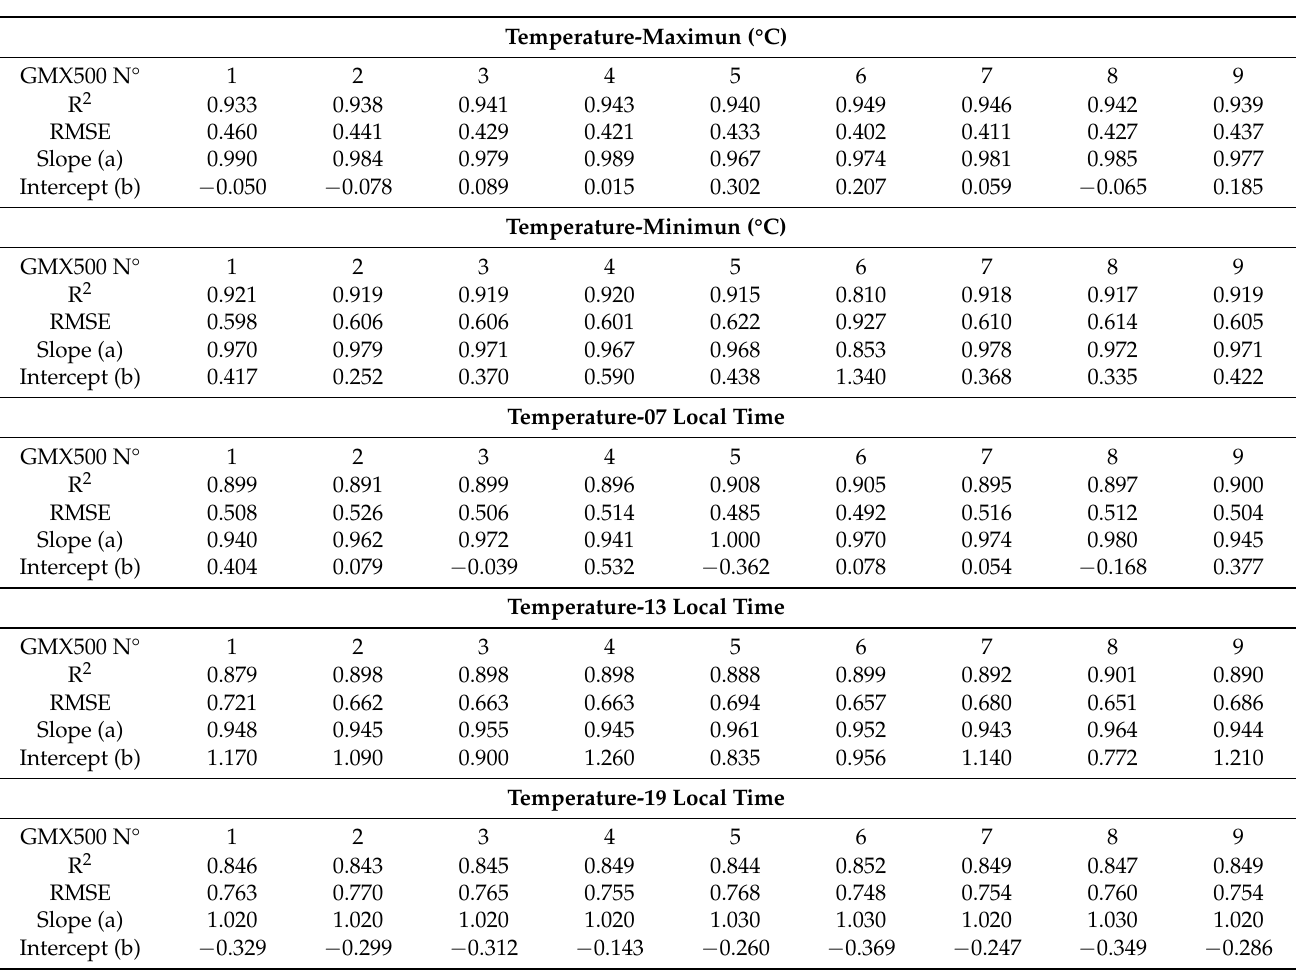
Table A1. Statistical results of the evaluation of temperature of the GMX500 sensors with a conven- tional weather station.